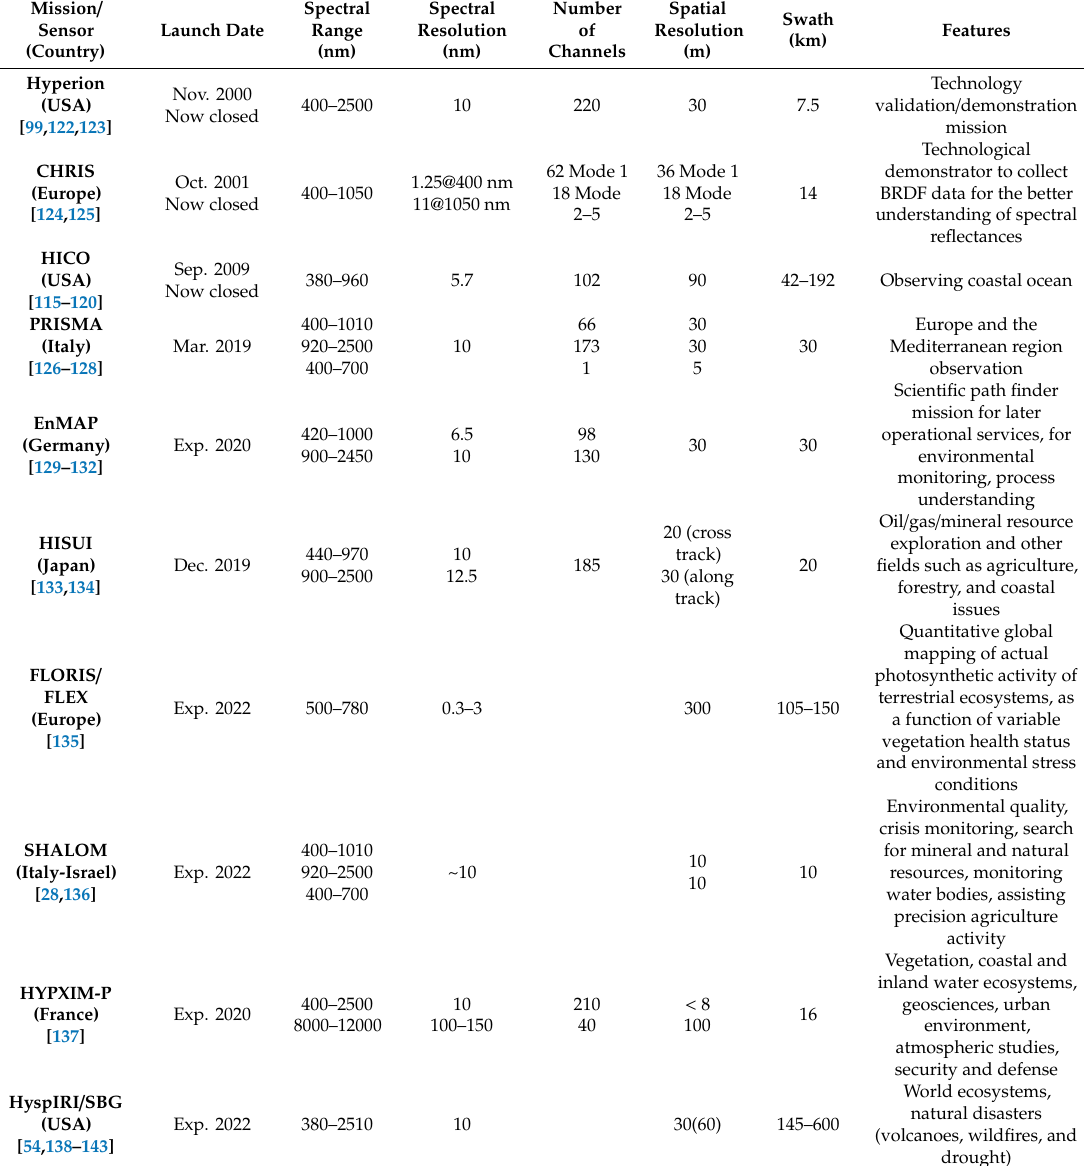
Table 2. Main features of some current and planned spaceborne hyperspectral imaging systems. BRDF: Bidirectional Reflectance Distribution